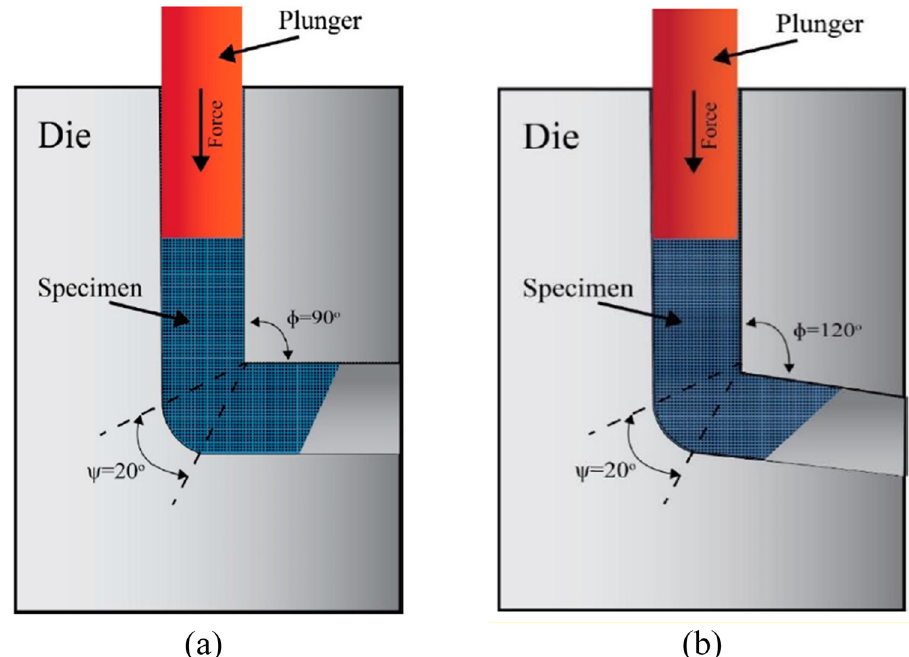
Figure 2: Schematic of the ECAP dies with internal channel angle of ( a ) 90° and ( b )